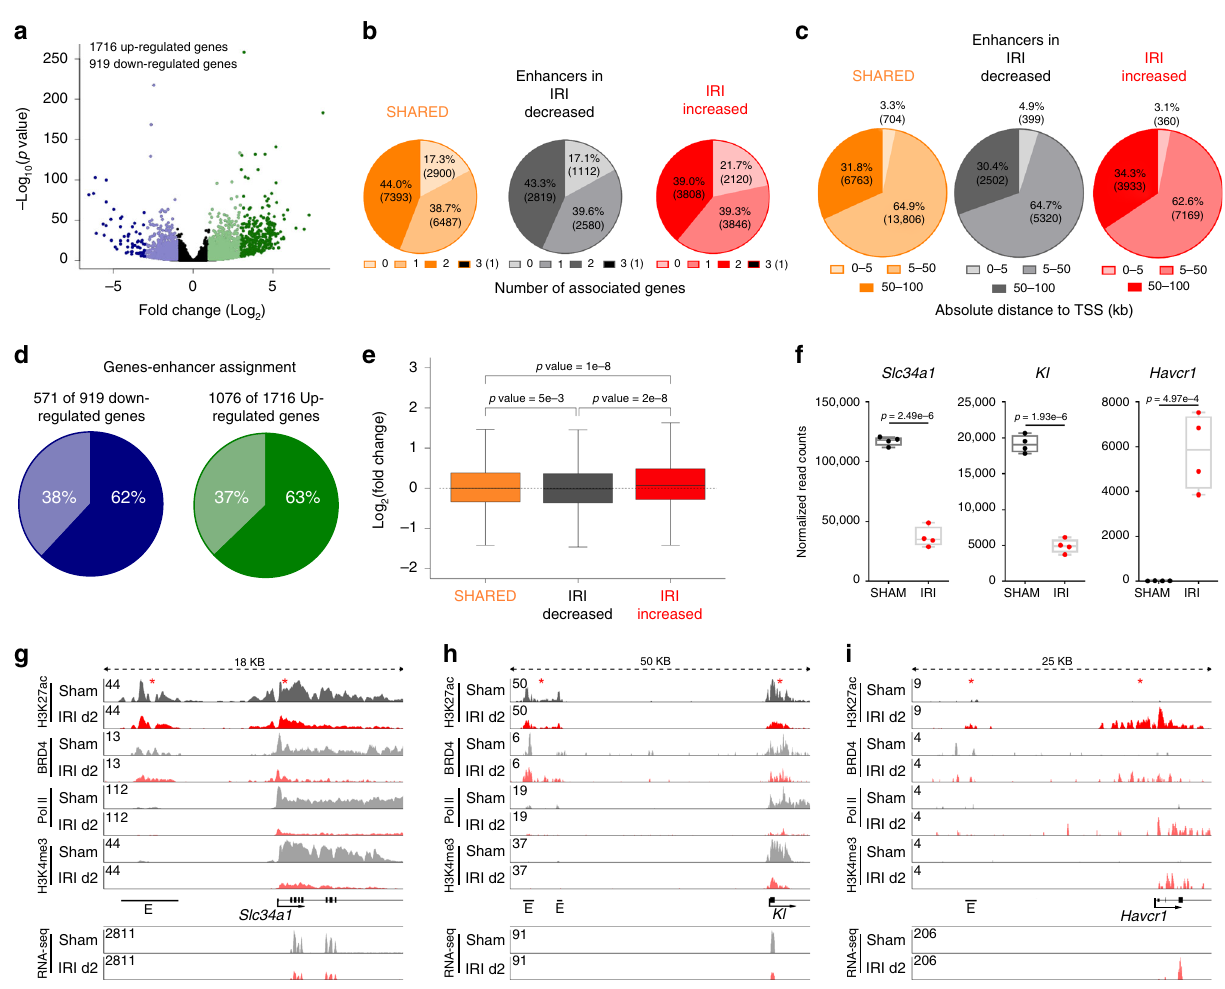
Fig. 2 Enhancer — gene annotation. a The volcano plot illustrates the 919 down- (blue) and 1716 upregulated genes (green) using RNA-seq data. b GREAT was used to annotate enhancers to genes. The pie plot shows how many genes were annotated to enhancer elements. c The pie plot illustrates the distance between the enhancers and their annotated genes (in kb to the transcriptional start site (TSS)). d 571 enhancer elements are annotated to the 919 downregulated genes (62%, dark blue). 1076 enhancers are assigned to 1716 upregulated genes (63%, dark green). e Genes associated with IRI-decreased enhancers ( n = 6512) are signi fi cantly downregulated, whereas genes assigned to IRI-increased enhancers ( n = 9774) have a signi fi cantly higher gene expression compared to genes assigned to SHARED enhancers ( n = 16781). Median, middle line inside each box; IQR (interquartile range), the box containing 50% of the data; whiskers, 1.5 times the IQR. One-way ANOVA with Tukey post hoc test was applied. f Slc34a1 and Kl are representative genes that were down-regulated in IRI day 2 when compared with SHAM. Havcr1(encoding KIM-1 ) is a gene signi fi cantly upregulated at IRI day 2. Two-sample t -test was applied (two-sided). Individual data points and box-plot with mean ± max, min are shown. n = 4 biologically independent samples g Illustration of the enhancer landscape of Slc34a1 . The indicated enhancers show a lower coverage of H3K27ac, and a strongly reduced coverage of BRD4 and Pol II with IRI compared to SHAM. The coverage of BRD4, Pol II and H3K4me3 is also strongly reduced over the promoter with IRI. RNA-seq track shows reduced expression on exon elements after injury. h Depiction of the enhancers associated to Kl . These enhancers show a strong decrease of H3K27ac, BRD4, and Pol II. In addition the promoter loses H3K27ac, BRD4, Pol II, and H3K4me3 binding. RNA-seq track shows reduced expression on exon elements after injury. i Havcr1 gains an enhancer element at IRI day 2. Also the promoter shows an increased coverage of H3K27ac, BRD4, Pol II, and H3K4me3. RNA-seq track shows increased expression on exon elements after